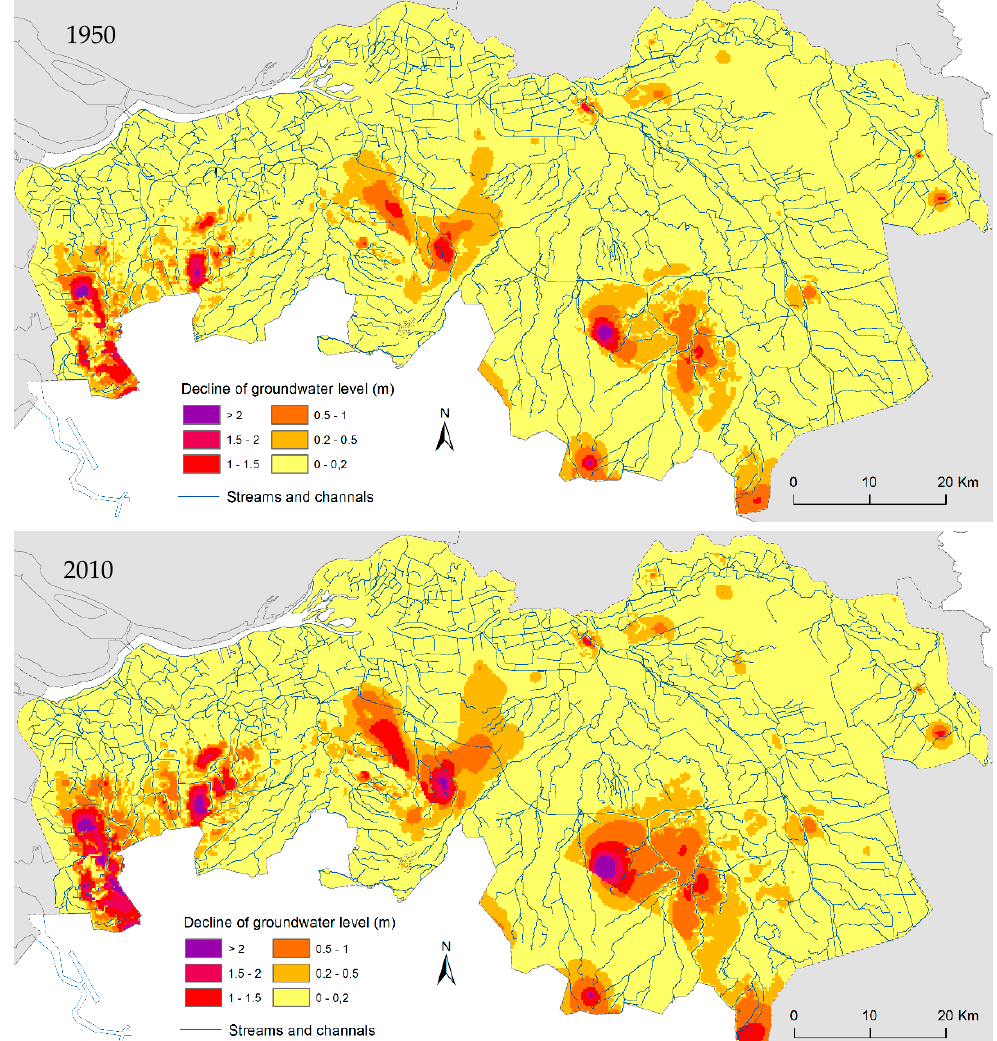
Figure 4. Simulated decline in groundwater level due to change in land use and increase of crop yields between 1950 and 2010.